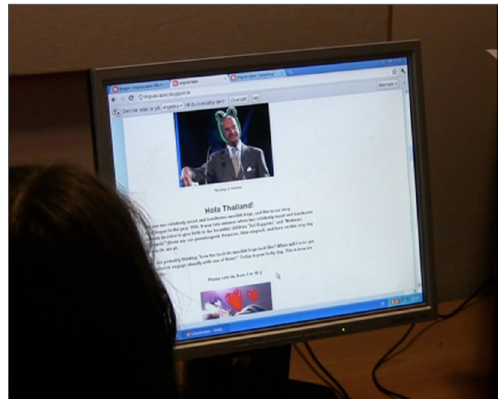
Figure 3. Screenshot of the posting including a picture of the Swedish